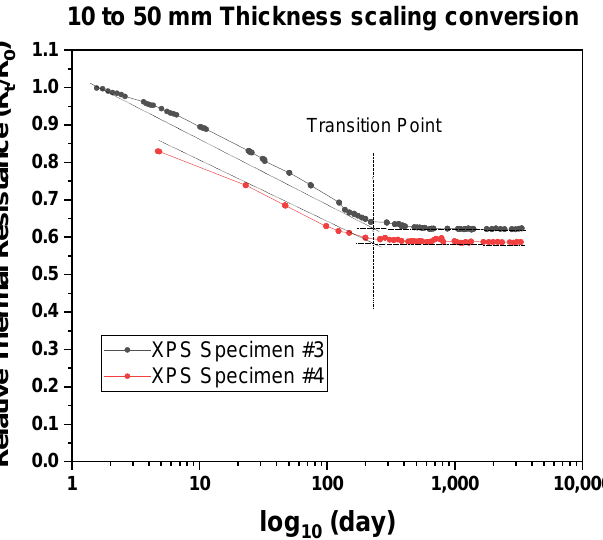
Figure 7. Relative thermal resistance on applying the scaling factor calculated by Equation (13).